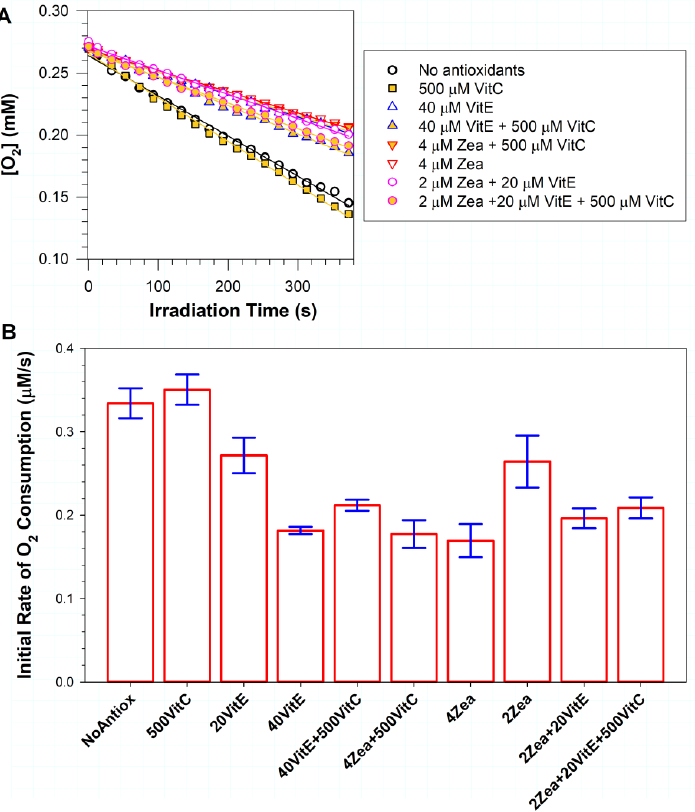
Figure 1. The effects of vitamin C (VitC), vitamin E ( α -tocopherol, VitE), zeaxanthin (Zea) and their combinations on photooxidation induced by ATR. ( A ) Representative kinetics of oxygen consumption during exposure of ATR-containing liposomes to blue light in the absence and presence of antioxidants at indicated concentrations in µM. Suspension of liposomes, consisting of 7 mg/mL EYPC, 0.5 mM ATR and indicated concentrations of lipophilic antioxidants, in the absence or presence of 0.5 mM vitamin C were exposed to blue light. The samples included 0.1 mM mHCTPO used as a spin probe. The initial linear portions of the kinetics were fitted to straight lines, and the slopes of these lines gave the initial rates of oxygen consumption. ( B ) The initial rates of oxygen consumption in the absence(NoAntiox) and presence of indicated antioxidants. The heights of the bars indicate the means, while the error bars indicate SDs.